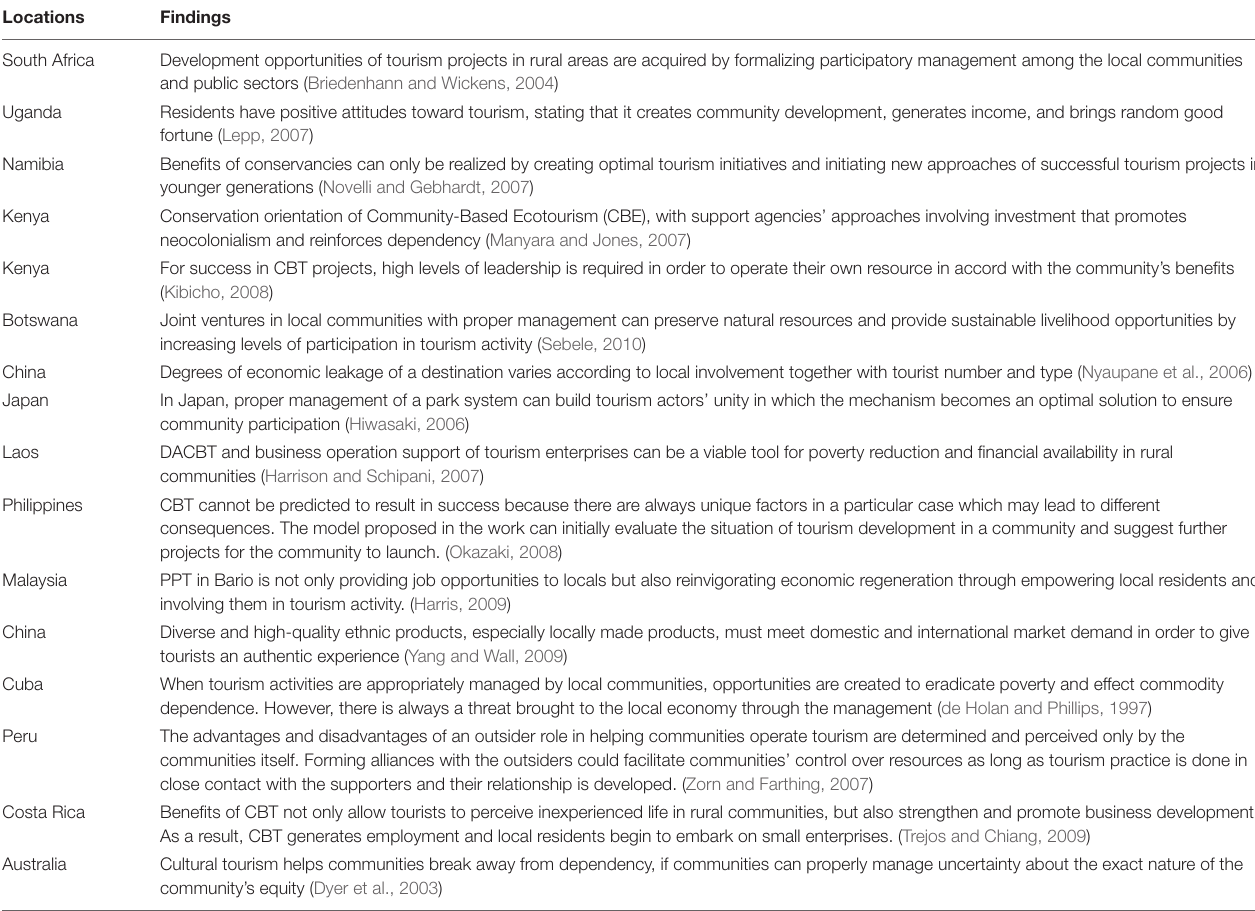
TABLE 1 | Academic literature in many CBT projects in Africa, Asia, Latin America, and Oceania. Locations Findings South